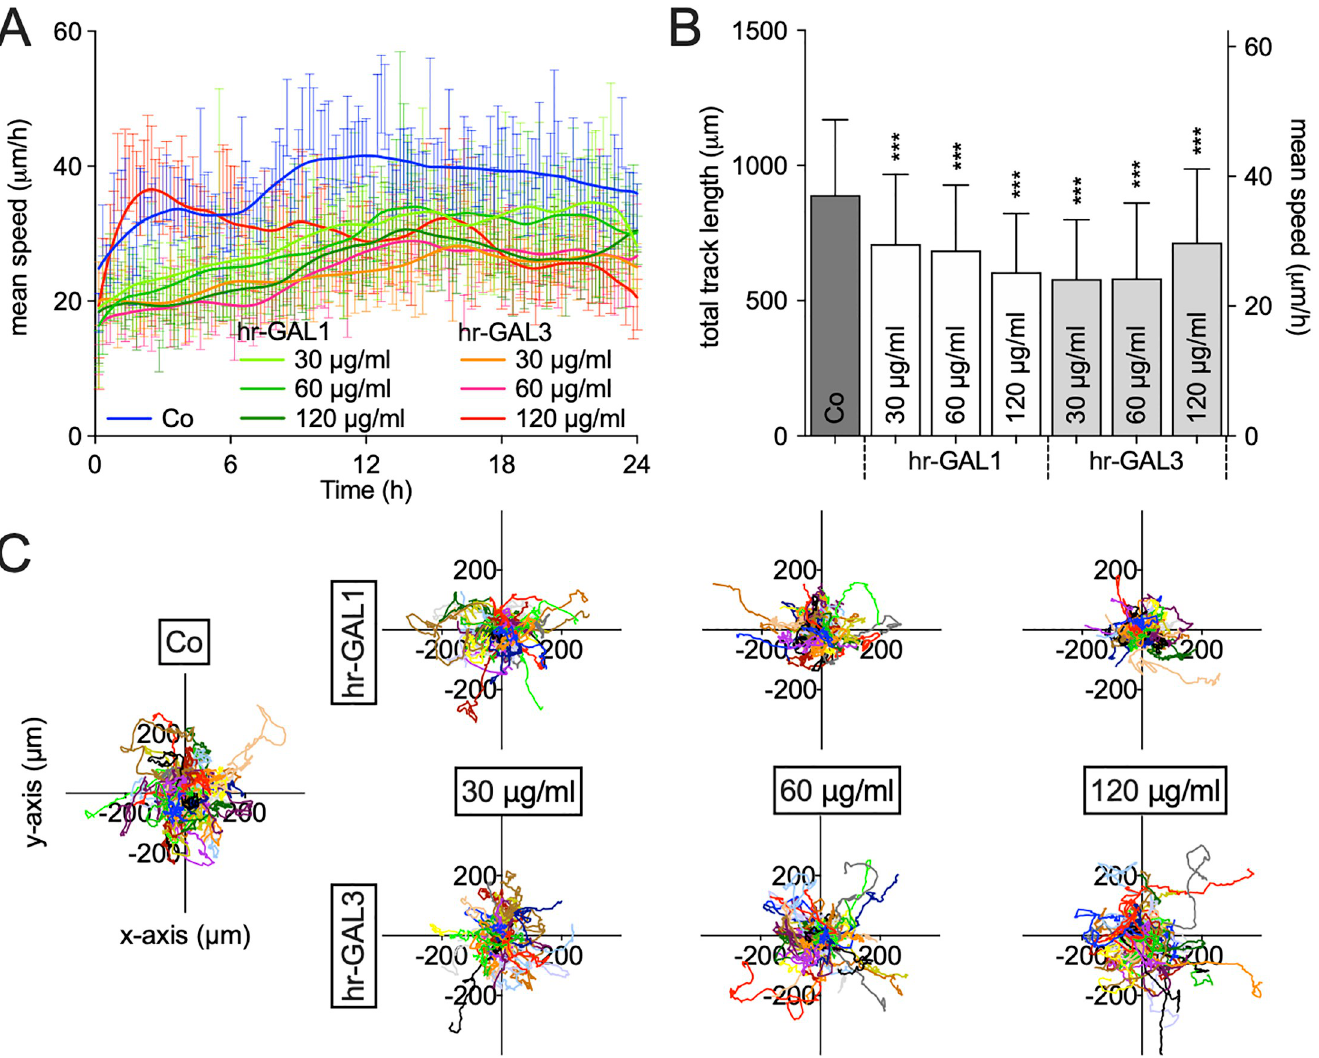
Fig 5. hr-GAL1 and 3 slow down cell velocity of HRMEC in vitro . Time lapse microscopy documentation of mean cell migration velocity at the documented time intervals (A), the overall mean velocity after incubation (B) and the single-cell superimposed cell tracks (C) during 24 h of incubation with 30, 60 and 120 μ g/ml hr- GAL1 or 3. Each color in (C) represents one superimposed cell track. � co vs all hr-GAL for velocity, ��� p < 0.001, n = 60 of 3 independent experiments.